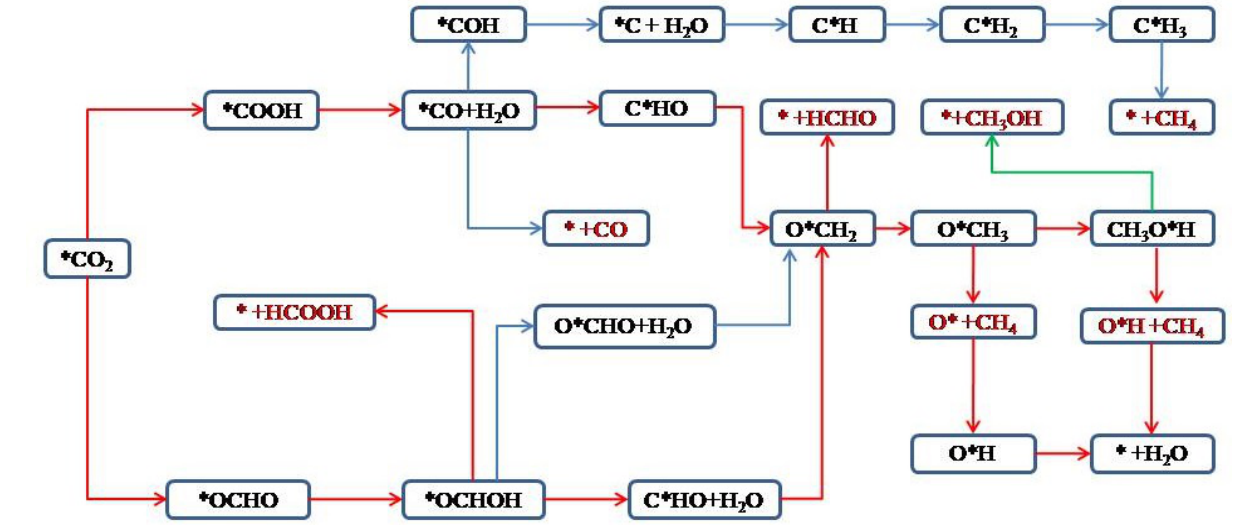
Figure 4. Flow chart of electrocatalytic CO 2 reduction to C 1 product scheme; red is the final product [61].